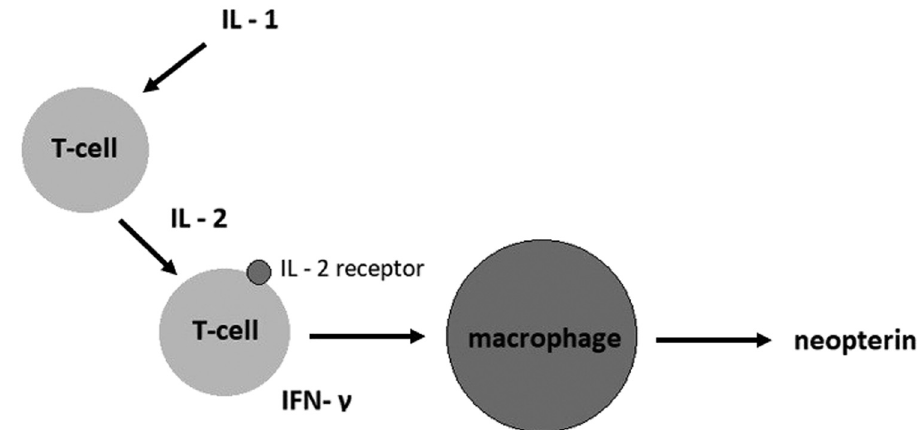
Figure 2: Macrophages and T - lymphocytes interact through cytokine like IFN - γ and IL - 1. With regard to T lymphocytes IL - 1 induces IL - 2 receptors that allow T - lymphocytes to respond to factorial - 2 while stimulating the IL - 2 production. Subsequently, IL - 2 triggers the pro - duction and secretion of IFN - γ .